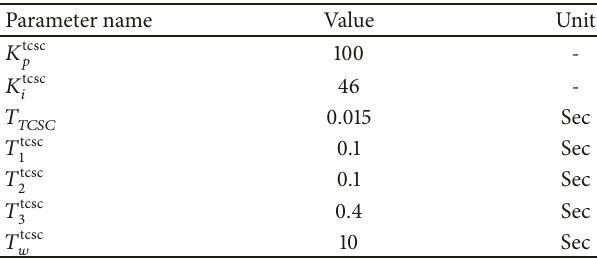
Table 1: The parameters of TCSC control